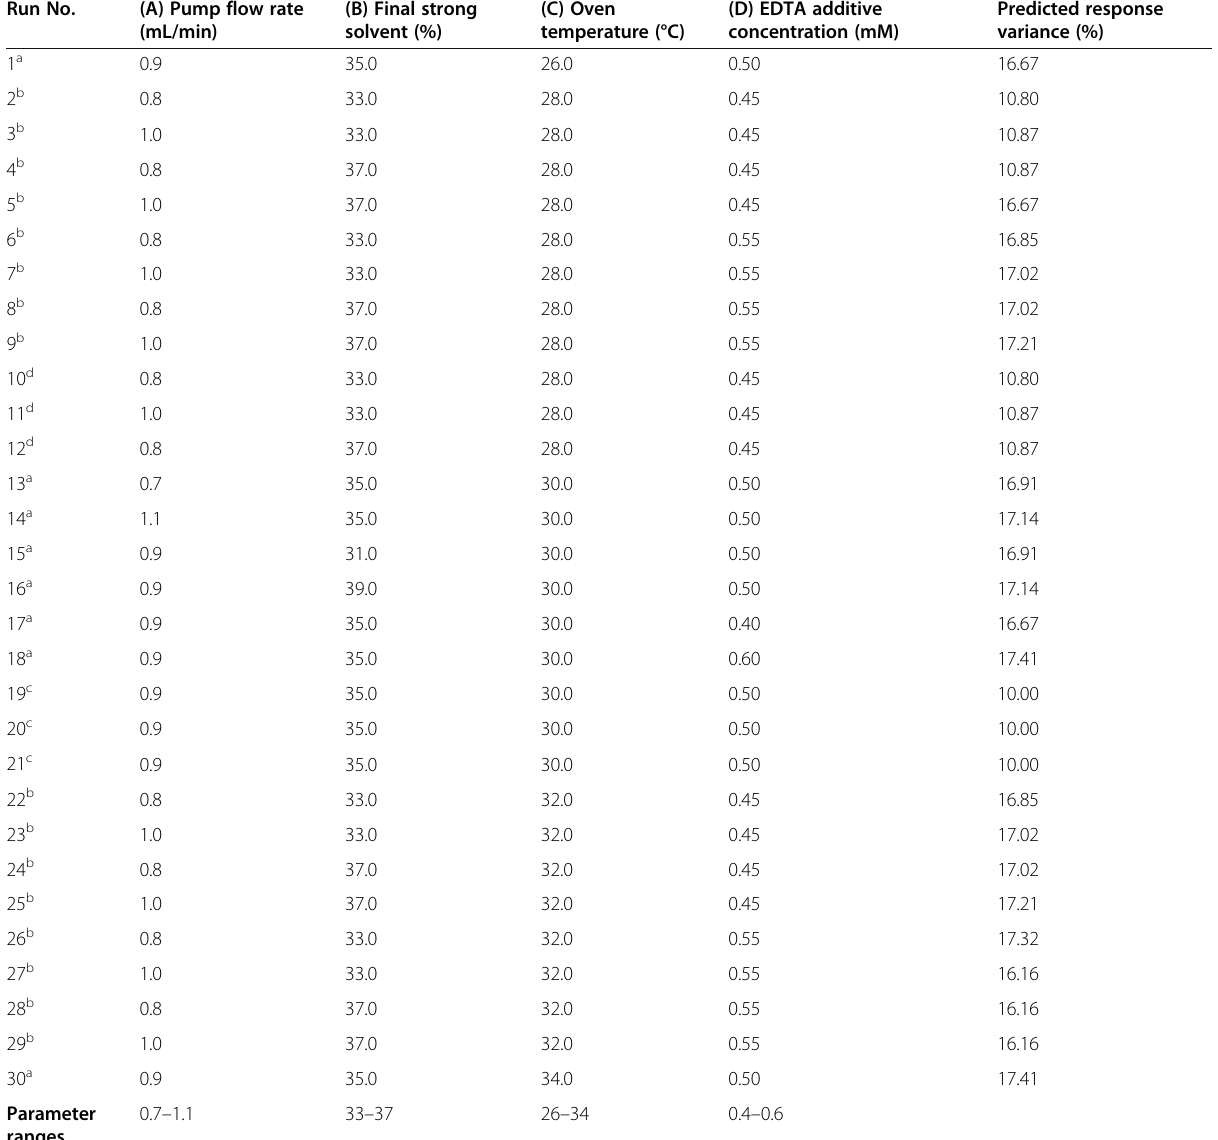
Table 1 The experimental matrix of the modified CCC design Run